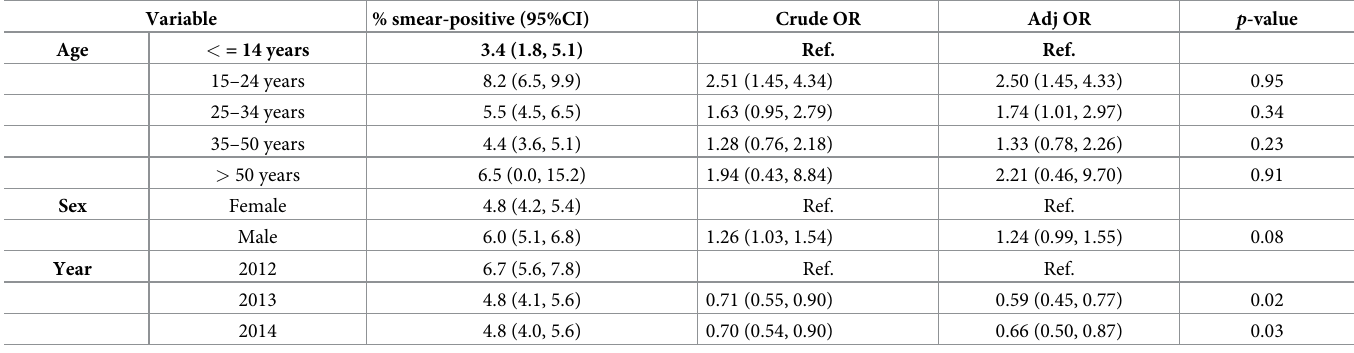
Adj = Adjusted, OR = Odds Ratio, Ref. = Reference